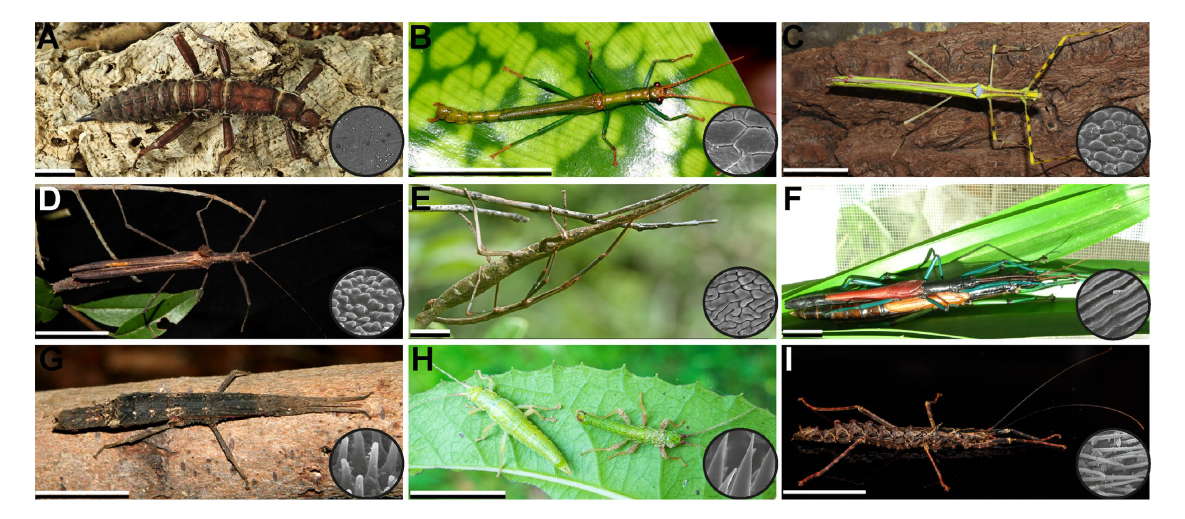
Figure 5: Diversity of stick insect ecomorphs and their respective euplantular AMS. (A) Eurycantha calcarata , female, smooth. (B) Dajaca monilicornis , male, hexagonal. (C) Anarchodes annulipes , female, flat pads. (D) Pseudophasma velutinum , female, small nubs. (E) Leiophasma sp., couple, maze. (F) Megacrania phelaus , couple, ridges. (G) Orestes mouhotii , female, long nubs. (H) Timema sp., couple, acanthae, image provided by S. Büsse. I. Dinophasma saginatum , female, hairy. Scale bars: 1 cm. Figure 5A–I were adapted from [108] (© 2018 Büscher et al., published by Frontiers, distributed under the terms of the Creative Commons Attribution License (CC